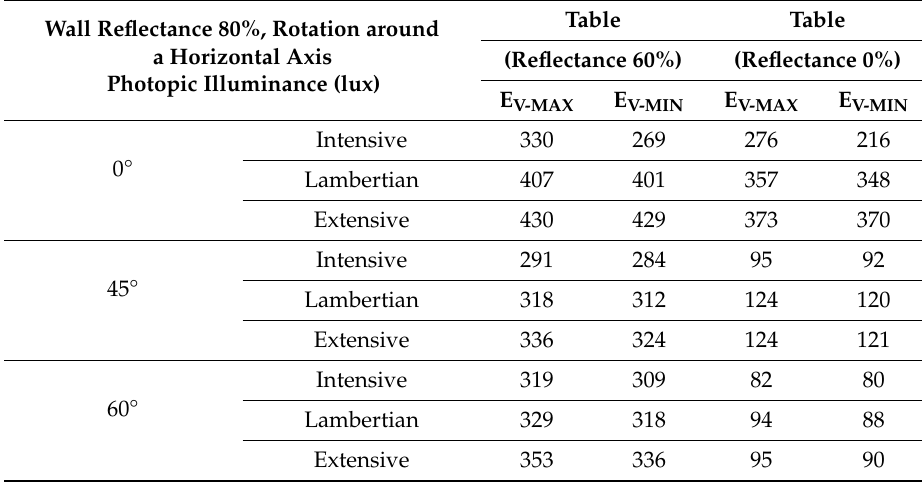
Figure 6. Graphical representation of the angular variation of the vision axis with respect to the horizontal axis; vertical illuminance at the eye-level plane (120 cm); wall reflectance of 80%. Table 5. Relationship between vertical illuminance at the eye-level plane (120 cm) with a wall reflectance of 80% and angular variation with respect to the horizontal axis.